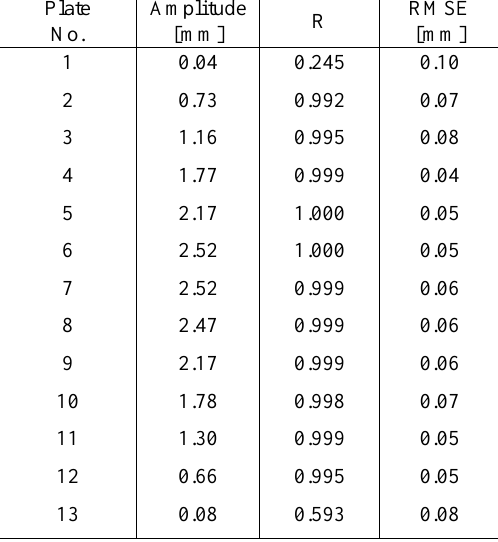
Table 9. Estimated amplitude, Pearson’s coefficient, and root Table 11. Estimated amplitude, Pearson’s coefficient, and mean squared error for all plates using medium